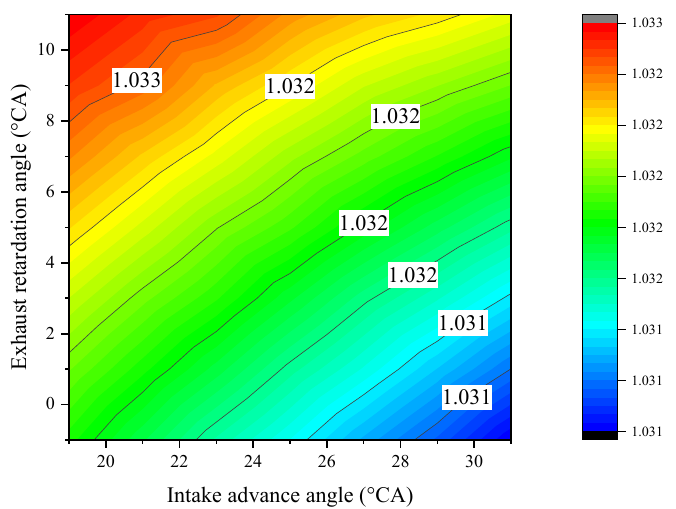
Figure 22. Back pressure versus the combined change of intake advance angle and exhaust retardation angle (point of operation: n = 3000 rpm, BMEP = 10 bar, CA50 = 8 °CA, throttle opening = 100%).